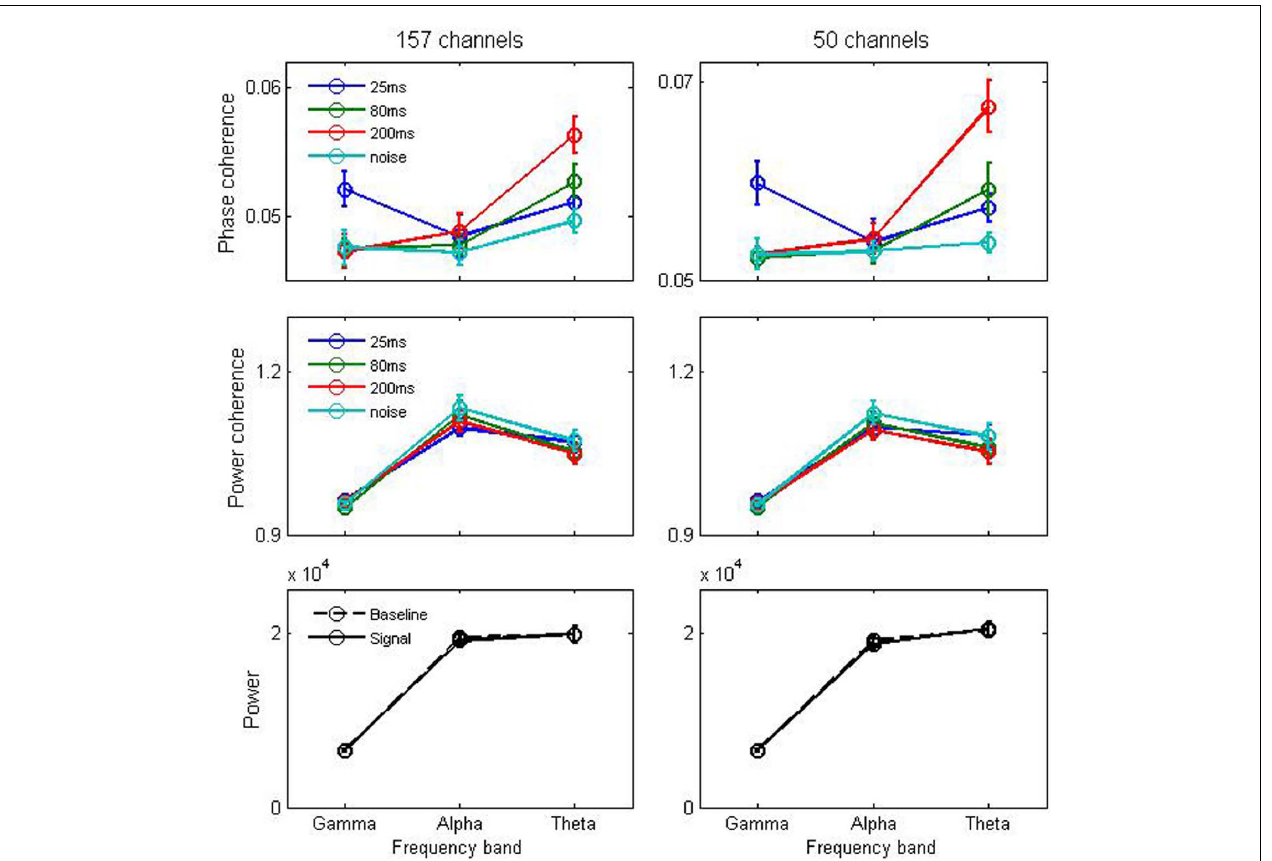
gamma and theta frequency bands, the matching stimulus (25 and 200ms stimulus, respectively) elicits the strongest cross-trial phase coherence. Middle panel: cross-trial power coherence at three different frequency bands for each of the four stimulus types. Lower panel: power before (baseline) and after (signal) stimulus presentation at different frequency bands. Error bars represents standard error across 12